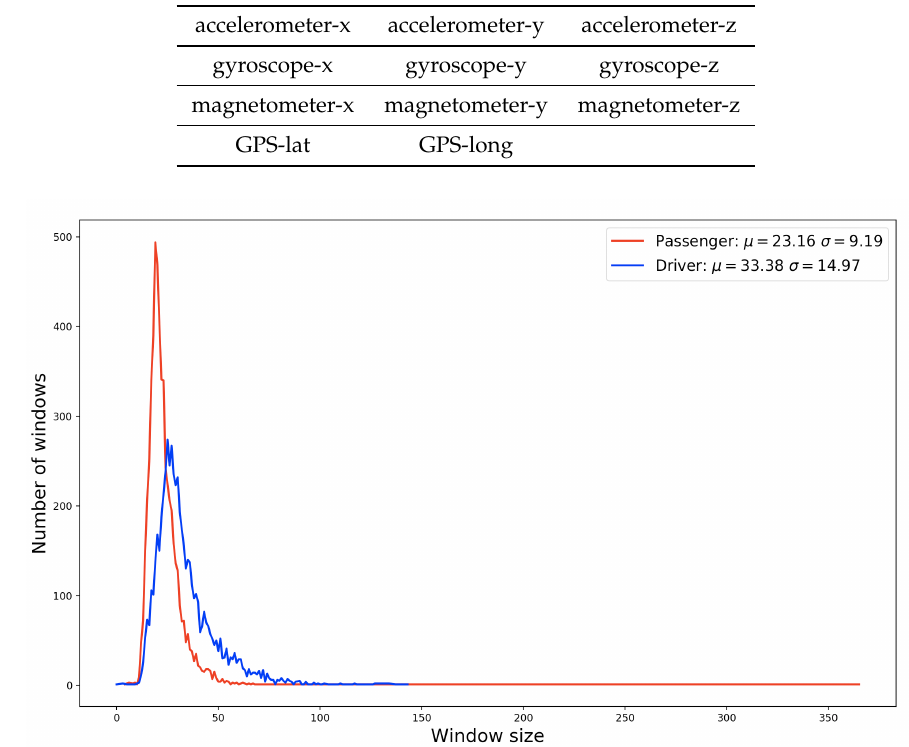
Table 2. List of sensors used during data collection.